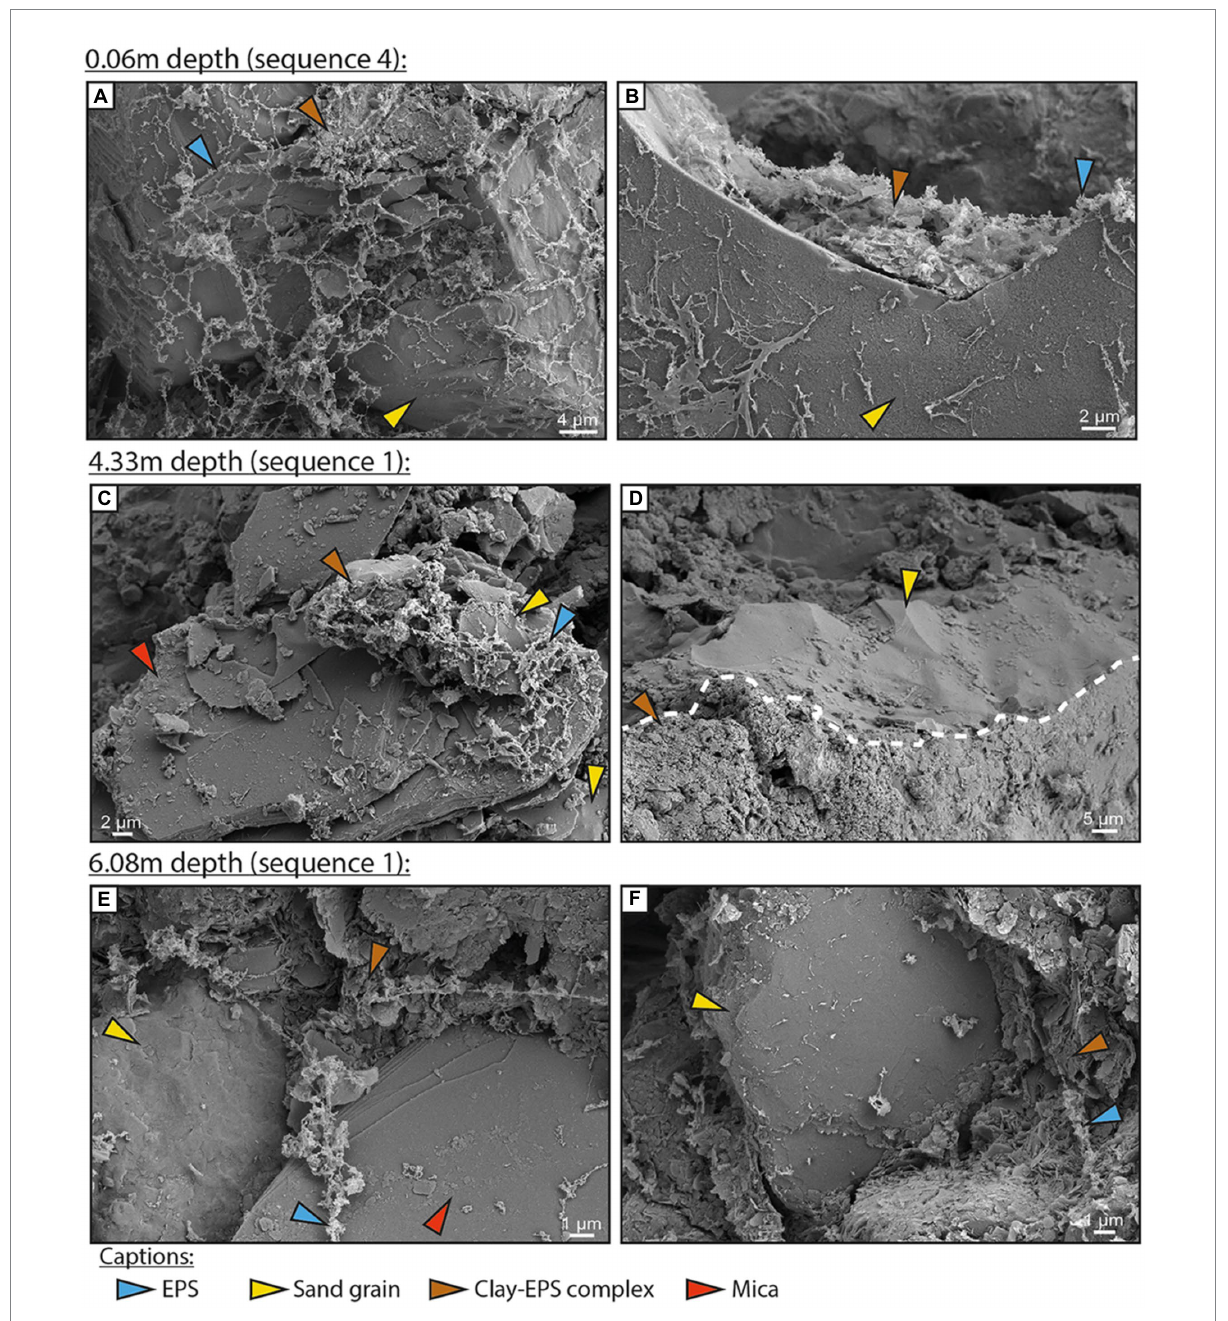
FIGURE 4 Cryo-SEM images of subsurface sediments from the BXN Long Core at three depths. Exopolymeric substances (blue arrow), quartz grain (yellow arrow), mica (red arrow), and clay-exopolymeric substance (EPS) complexes (brown arrow). (A,B) Depth of 0.06 m. Alveolar EPSs cover a large part of a quartz grain. EPSs are locally complexed to clay particles, forming a detrital clay coat. (C,D) Depth of 4.33 m. A clay-quartz-EPS complex covers a large part of a mica (C) . A sand quartz grain is fully covered by a clay-rich detrital coat (D) . (E,F) Depth of 6.08 m. EPS fibers are partially covered with clay platelets and coat both quartz and mica grains (E) . The surface of a quartz sand grain is partially coated by a dense clay-EPS complex (F)